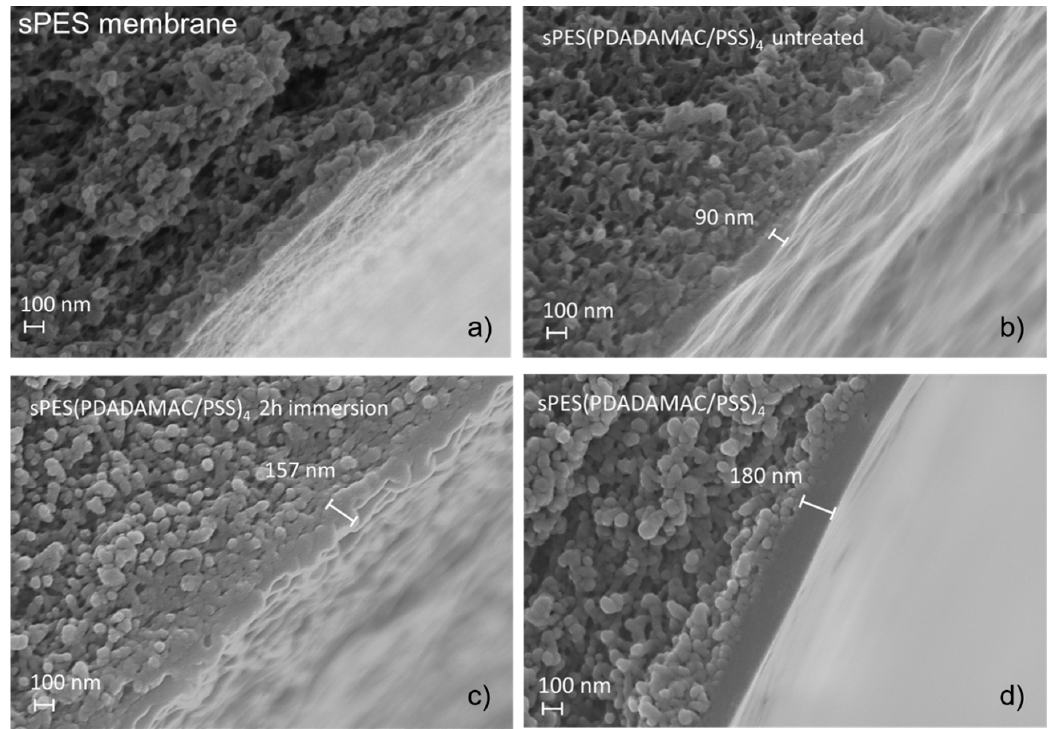
Figure 4. SEM images of sPES (sulfonated polyethersulfone) membranes; ( a ) uncoated membrane, ( b ) membrane after LbL coating, ( c ) coated LbL membrane after immersing for 2 h in phosphoric acid, ( d ) coated LbL membrane after 2 h of phosphoric acid filtration.